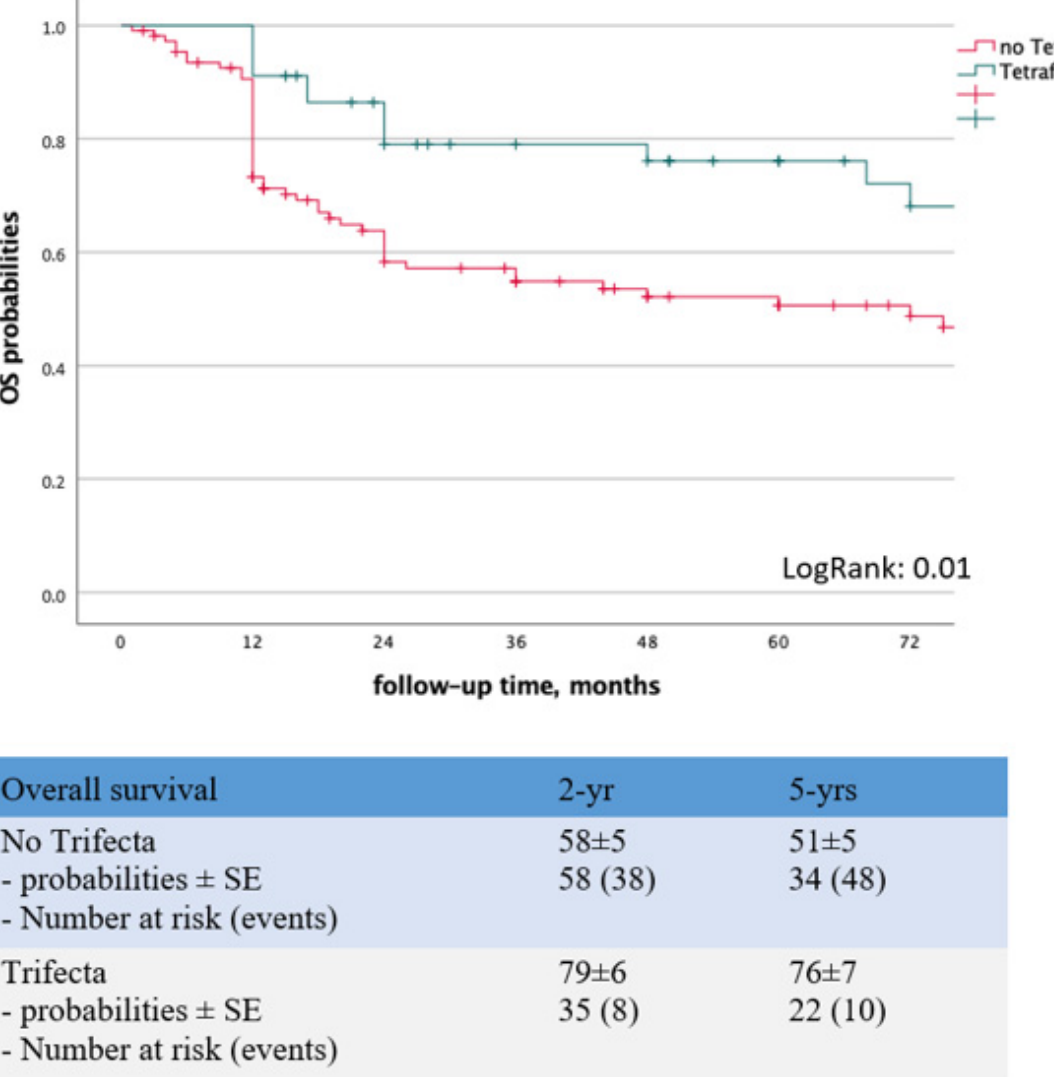
Figure 2. Kaplan–Maier analysis to assess the predictive role of Trifecta achievement on OS proba- bilities. Table 2. Univariable and multivariable logistic regression analyses to identify predictors of Tetra- fecta achievement.